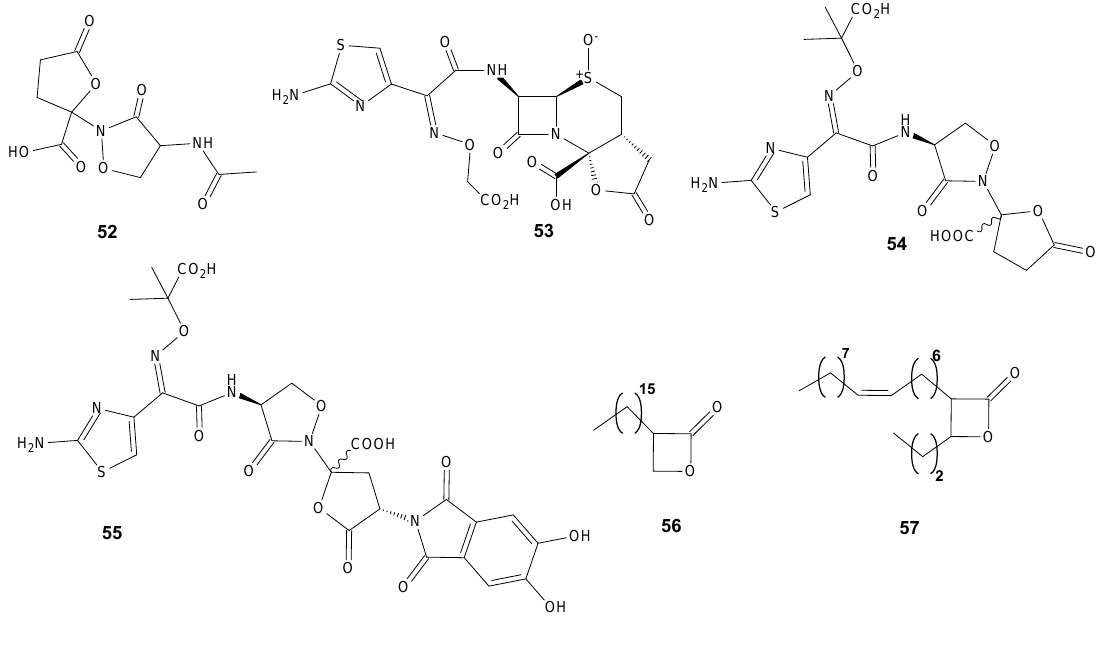
Figure 6. Lactones 52 – 57 . On the basis of described by Lehmann et al. [60] of the activity of β -lactones to- wards M. tuberculosis , new modification of the structure was also designed and some α , β - disubstituted β -lactones were tested towards different mycobacterial pathogens. Among the 16 β -lactones, 3-hexadecyloxetan-2-one ( 56 ) (Figure 6) exhibited significant activity against M. abscessus , whereas most of the β -lactones showed promising activities against M. marinum , similar to that of the isoniazid. There were 6 compounds found to be ac- tive against M. tuberculosis , with trans -( Z )-3-(hexadec-7-en-1-yl)-4-propyloxetan-2-one ( 57 ) (Figure 6) being the best growth inhibitor with an MIC 50 value reaching 19.7 µ g/mL [79]. Based on the previous findings on Ocotillol antibacterial activity (triterpene isolated from Fouquieria splendens Engelm.), a series of novel ocotillol-type lactone derivatives were designed and synthesized. The five-step synthesis started from 20( S )-protopanaxadiol (PPD, 58 ) and included the protection of hydroxyls by acetic anhydride, epoxidation followed by nucleophilic addition in situ to target the tetrahydrofuran derivative, oxidation by Jones reagent to provide acetylated lactone, and, afterwards, removing the protecting groups and subsequent reaction with acids, anhydrides or amino acid to afford the target Ocotillol derivatives (Figure 7). Among the tested derivatives, compounds 63 and 64 were found to be the most active with minimum inhibitory concentrations of 1–4 µ g/mL against Gram- positive bacteria, and at the same time, they exhibited low cytotoxicity against normal and cancer cell lines. The synergistic effect was tested with kanamycin and chloramphenicol and results showed that compounds 63 and 64 enhance the susceptibility of MRSA